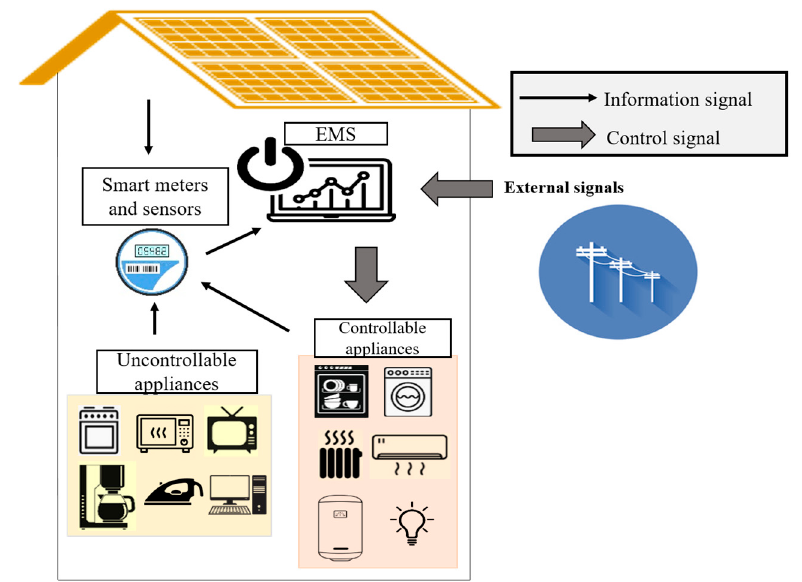
Figure 9. A smart prosumer in a smart-city.